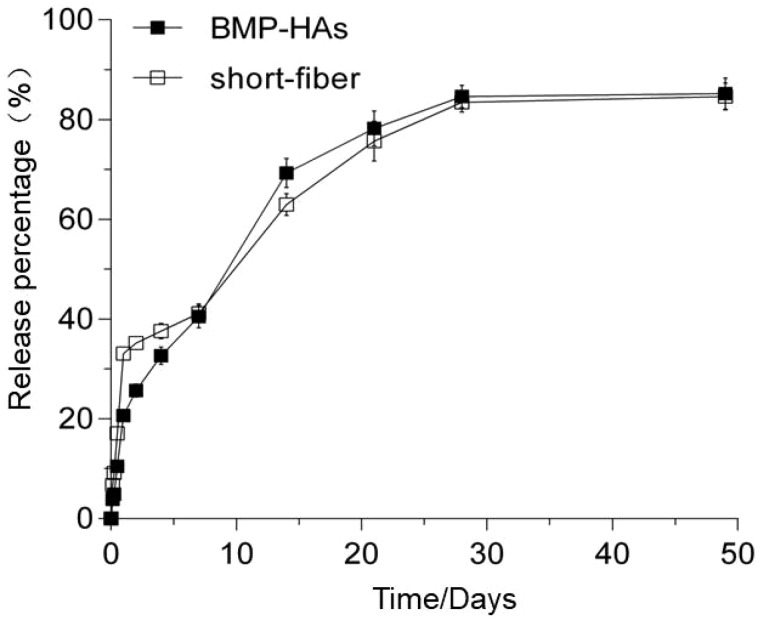
Cumulative release curves of BMP-2 from PLLA fibers dispersed in solution and fiber-coated HA scaffolds (BMP-HAs, all n = 9)